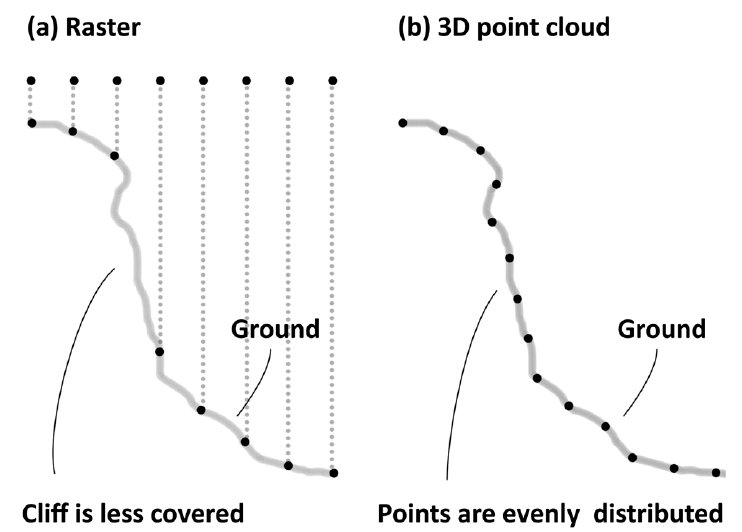
Figure 2. Comparison of rasterized and point cloud terrain models. On the gridded terrain surface, the point density is not homogenous ( a ) and the near vertical face is underrepresented; however, in the 3D point cloud, the points can be evenly distributed ( b ).